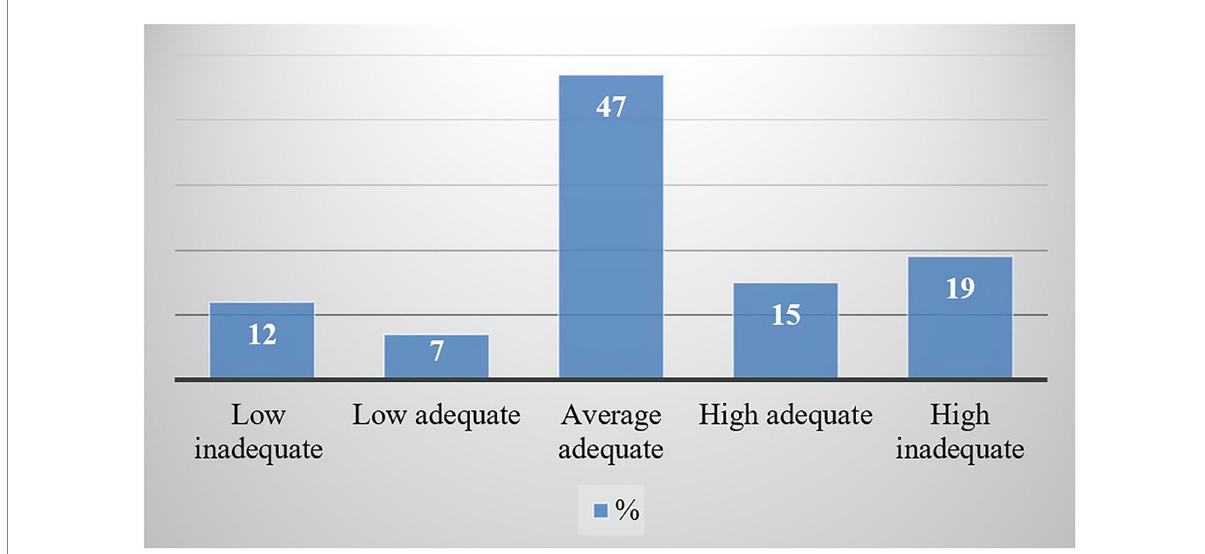
FIGURE 4 Self-assessment among students.